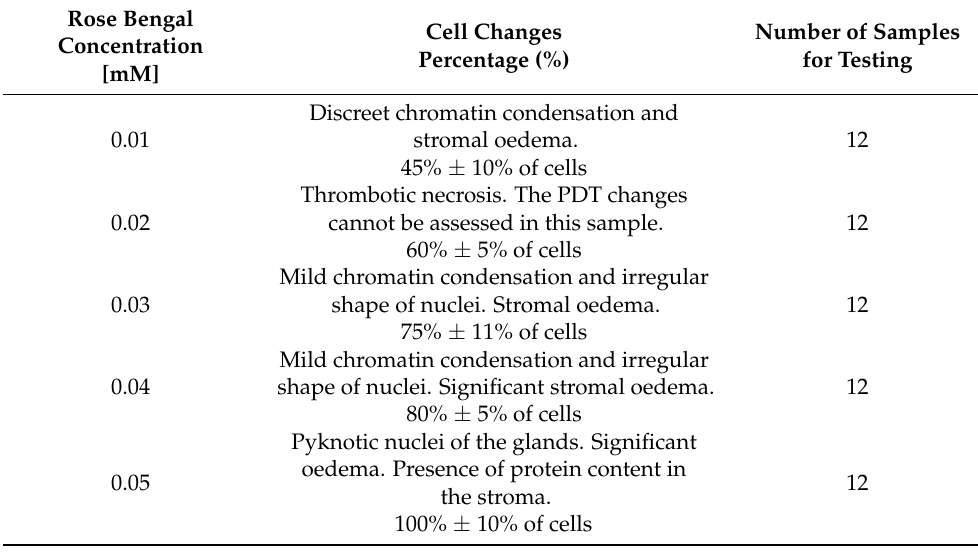
Table 4. Microscopic changes after PDT